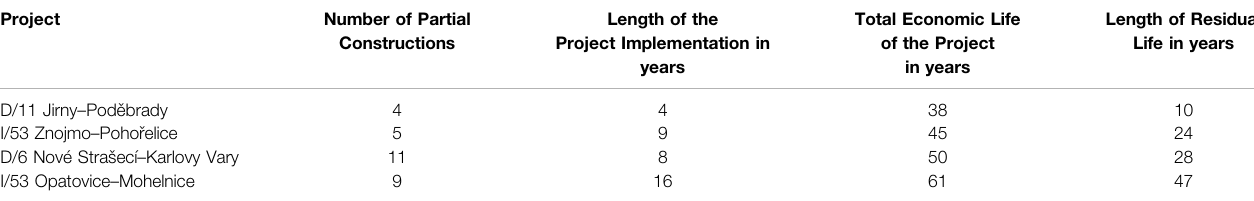
TABLE 2 | Project variable values, incl. original residual values and residual